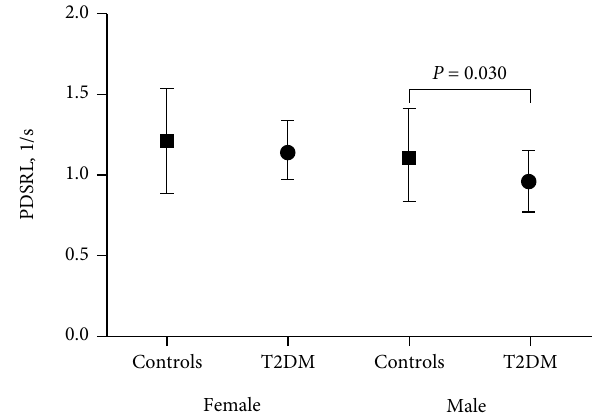
Figure 3: Sex di ff erences in myocardial function between control and T2DM subjects. PDSRL: peak longitudinal diastolic strain